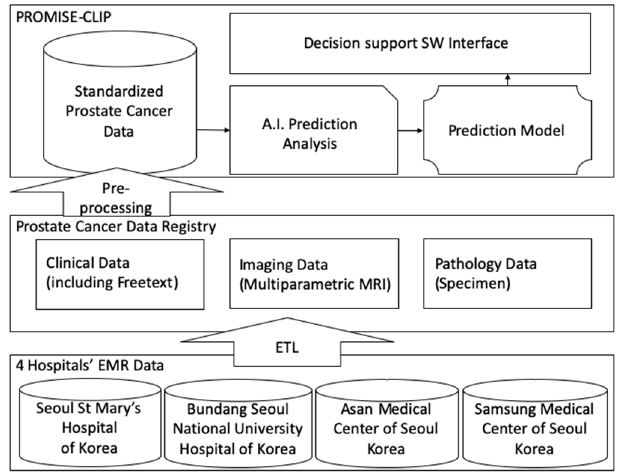
Figure 3. Conceptual diagram of PROMISE CLIP.